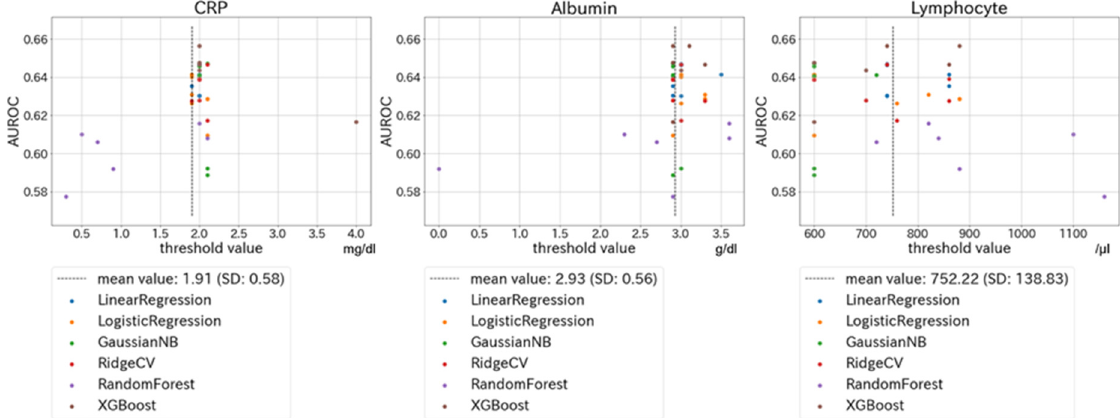
Figure 3. Scatter plots of cut-off values for biomarkers and corresponding AUROCs in 36 models. Figures show scatter plots of cut-off values for biomarkers in 36 models (i.e., six machine-learning models and six combinations of the order of biomarkers). The threshold values on the horizontal axis represent the best results for each model and order. Abbreviations: AUROC, area under the receiver operating characteristic; CRP, C reactive protein.